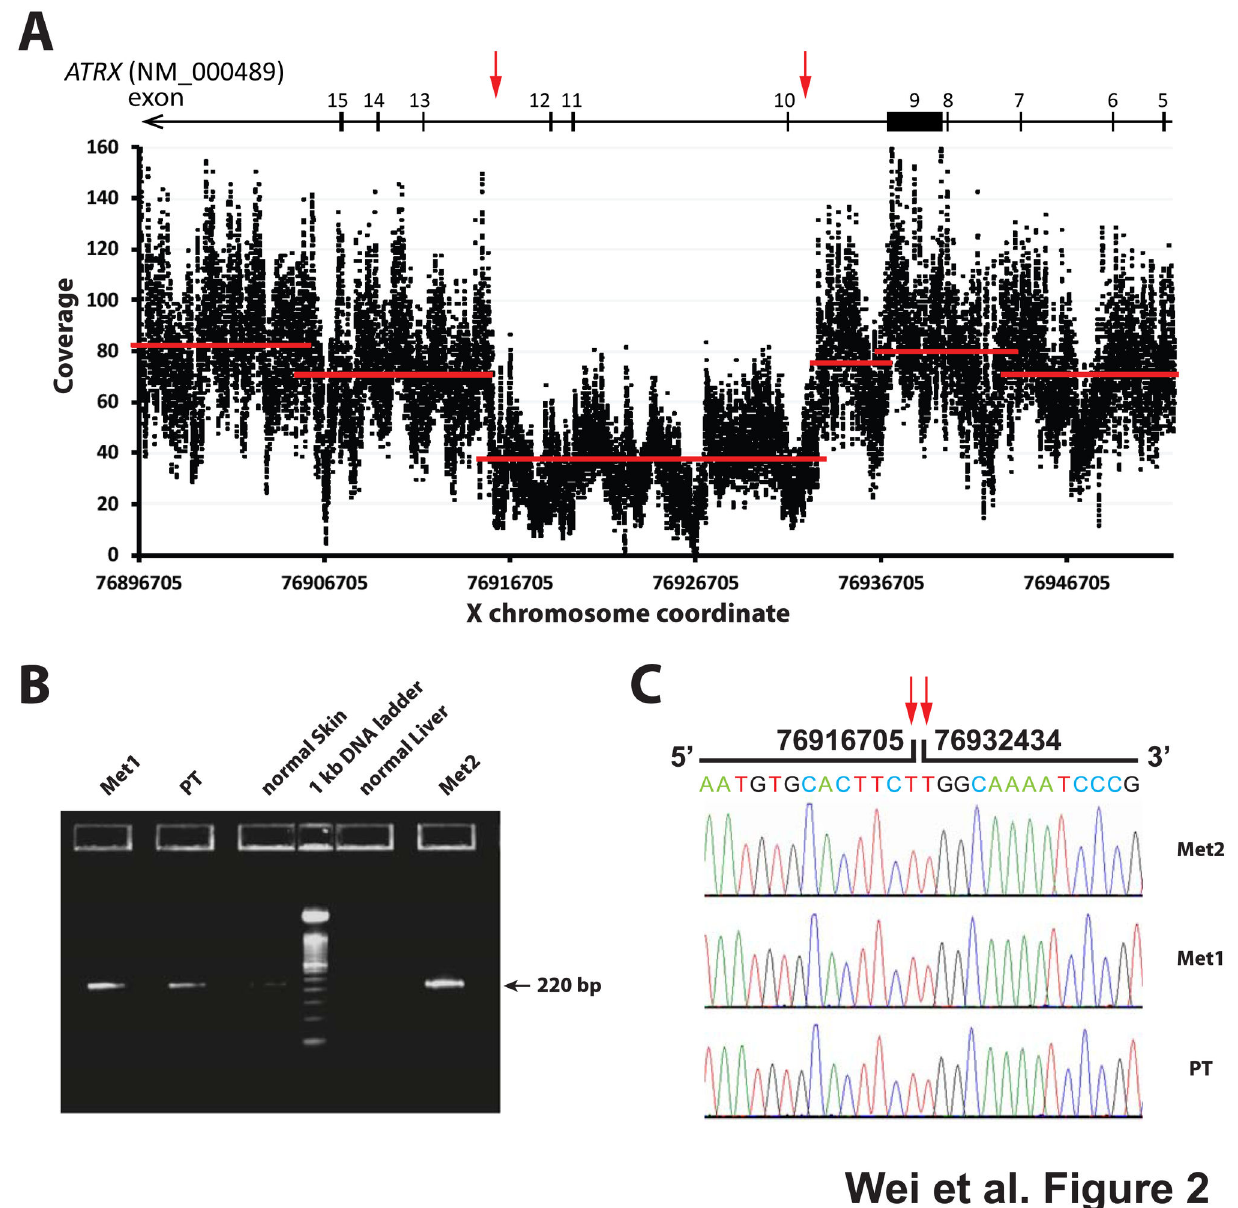
Figure 2. A focal hemizygous deletion in the ATRX gene in all three tumor samples. ( A ) Base coverage of X chromosome from whole genome sequencing detected a hemizygous deletion in the ATRX genes from 76916706 to 76932433 (marked by red arrows). Each black dot represents a base, and red lines denote average coverage of each segment using circular binary segmentation[67]. Transcript NM_000489 was used for the exon annotation of the ATRX gene. ( B ) Genomic PCR verified the somatic deletion in the ATRX gene using a pair of genomic PCR primers flanking the predicted deleted region on the X chromosome. As result of the deletion, an abnormal PCR product of 220bp was detected in tumor DNAs, but not in the germline DNAs on a 2% TBE-agarose gel. ( C ) Sanger sequencing of the genomic PCR products confirmed the deletion of ChrX: 76916706-76932433 was the same among all three tumors . doi: 10.1371/journal.pone.0077731.g002 the 12 had detectable level of mutant alleles (Figure 3A, lower fraction of mutant allele (>30%) in their transcripts (Figure 3A, panel). Only 3 genes ( NUFIP1 , GATA2 , and LPAR1 ) had high lower panel), suggesting their potential roles as driver